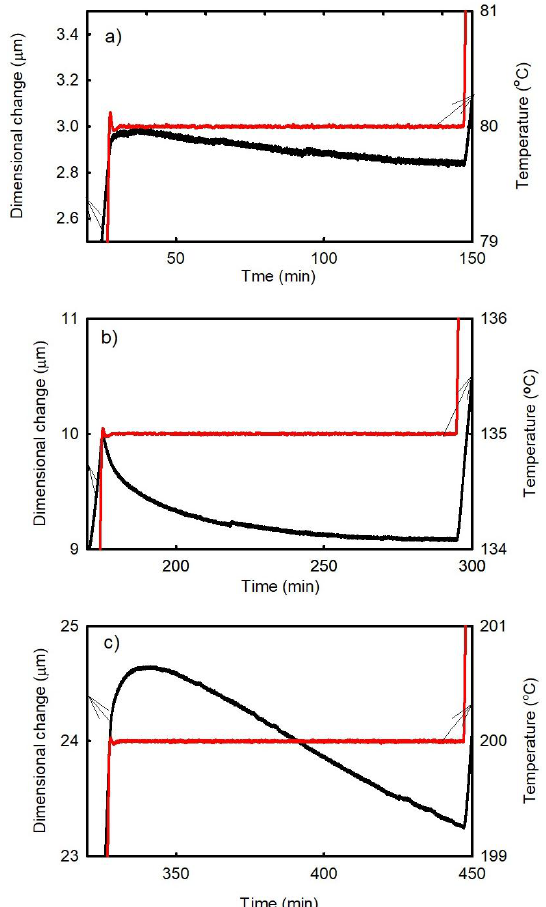
Figure 11. Time dependences of the dimensional changes of the B1 sample (FR4 laminate/Cu plated holes) observed at ( a ) 80 °C, ( b ) 135 °C, and ( c ) 200 °C.